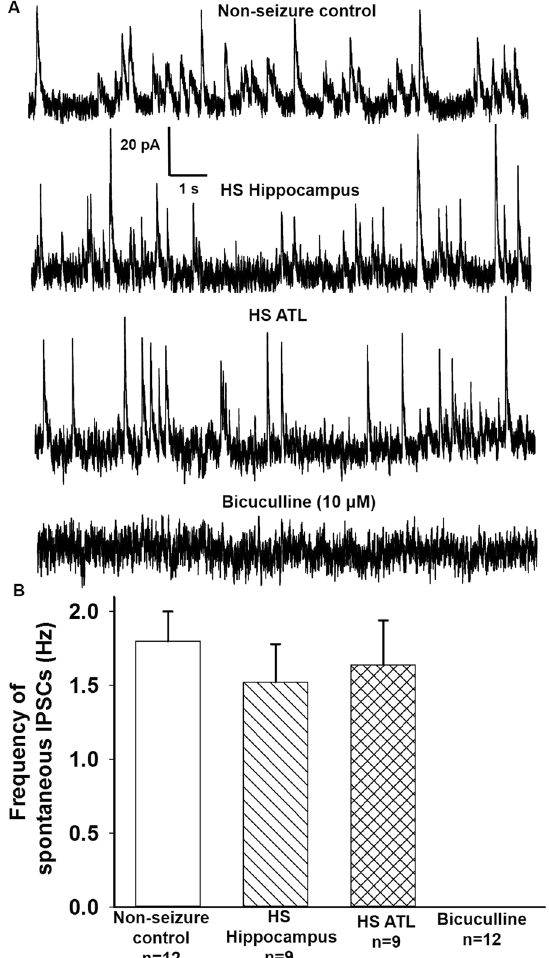
Figure 3. Spontaneous IPSCs from pyramidal neurons of resected brain samples. ( A ) Sample recordings of spontaneous GABAergic PSCs at 0 mV obtained from pyramidal neurons of non-seizure control, and the hippocampal and ATL samples obtained from patients with HS. Bottom trace shows recordings at 0 mV 10 min following superfusion of a HS hippocampal slice with ACSF containing GABA A receptor antagonist bicuculline (10 μ M). ( B ) Mean frequency of GABAergic PSCs recorded from (i) non-seizure controls, (ii) HS Hippocampal sample, (iii) HS ATL sample and, (iv) bicuculline treatment. Graph and error bars represent mean and S.E.M., respectively, of data obtained from twelve non-seizure control samples from twelve patients, and nine hippocampal and ATL samples obtained from nine patients with